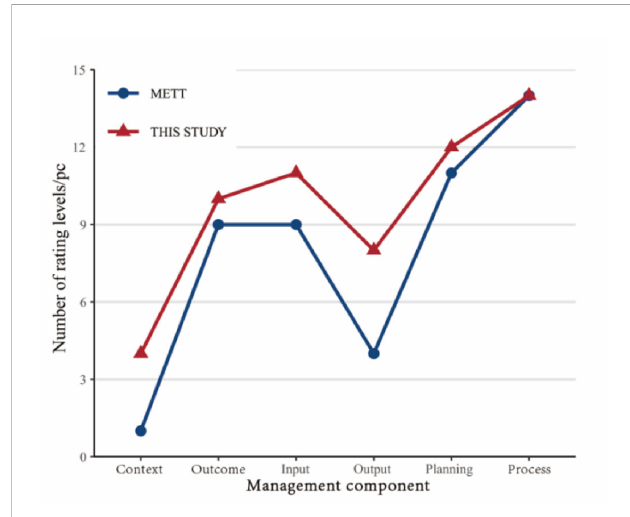
FIGURE 1 Comparison of METT based on 27 protected areas in the East China Sea with the assessment results of this study framework. Scores in the fi gure are the scores of different components in the assessment of protected areas under different